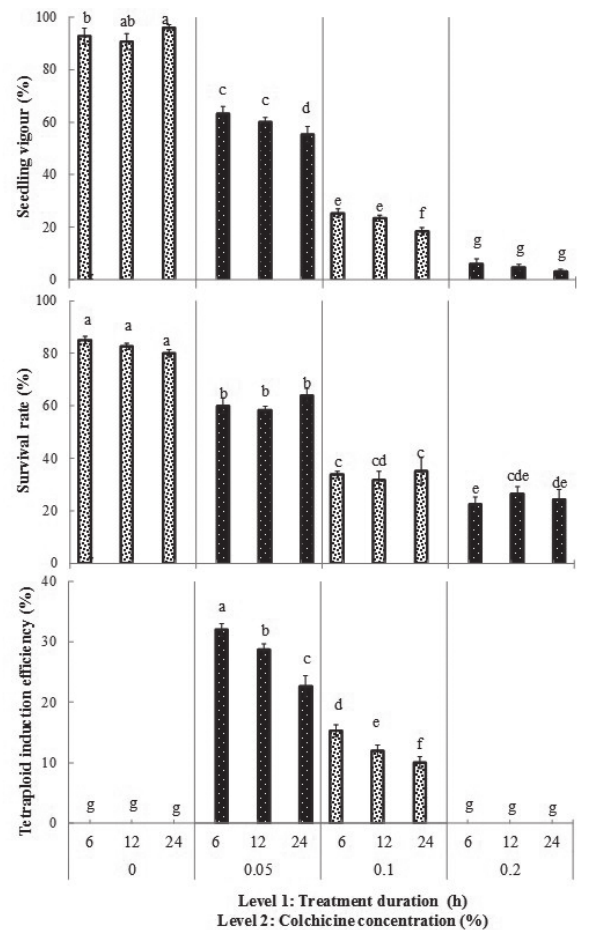
Figure 1. Effect of colchicine concentration and treatment duration on seedling vigor (a), survival rate (b), and polyploidy induction efficiency in S. mutica explants (mean ± standard